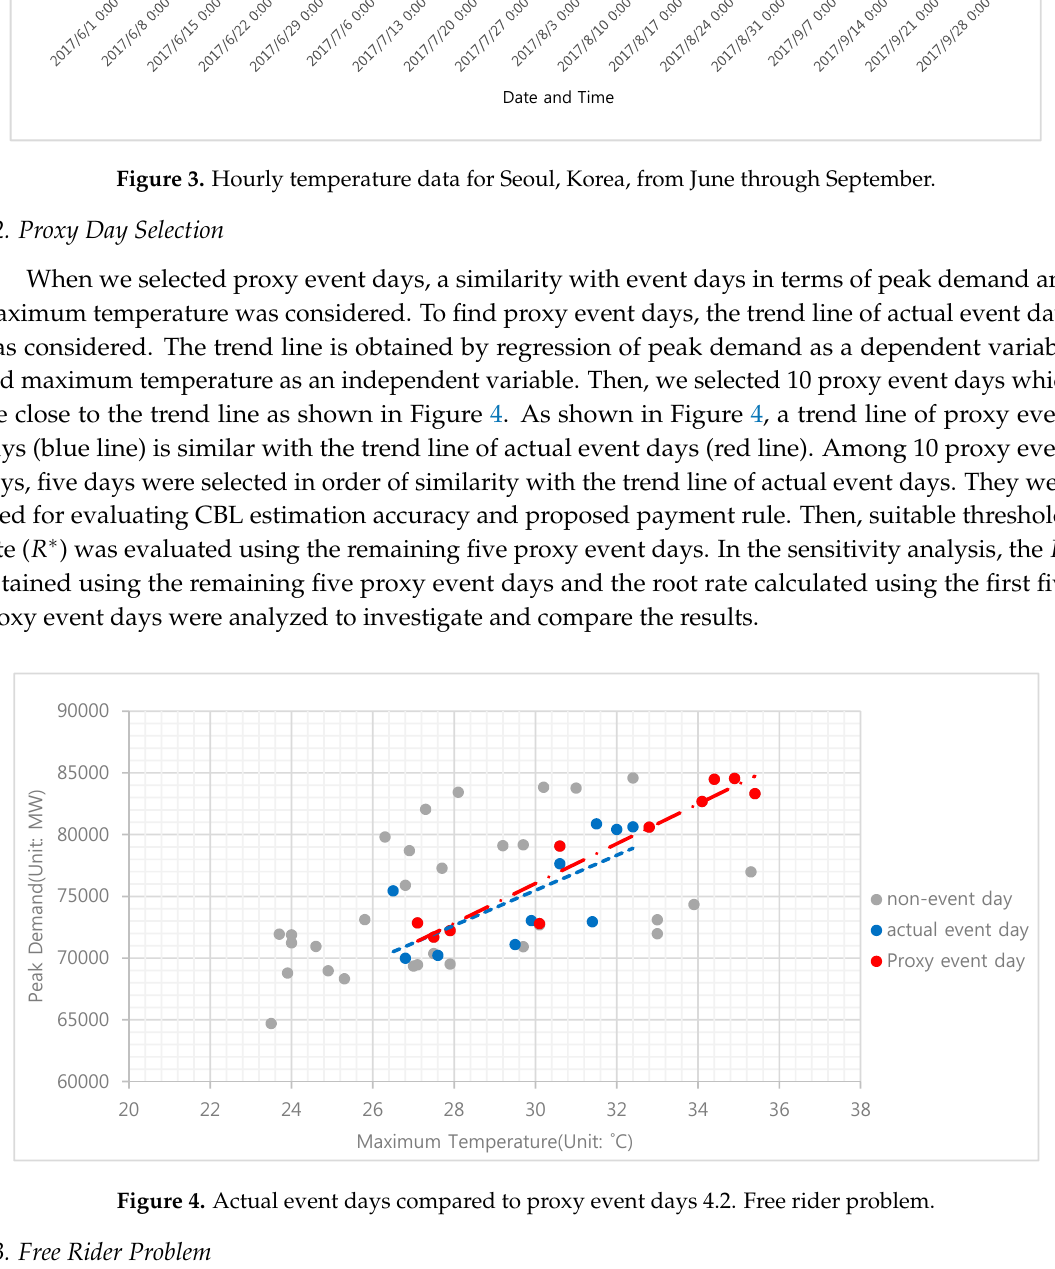
Figure 3. Hourly temperature data for Seoul, Korea, from June through September.